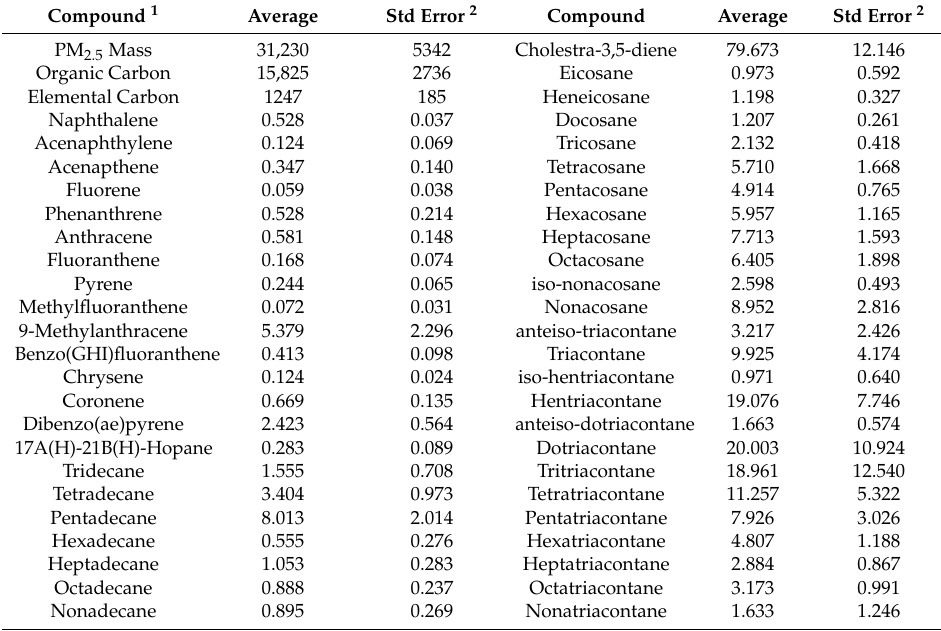
Figure 2. Mass fragments of Cholesta-3,5-diene in the surgical smoke by gas chromatography mass spectrometry—thermal desorption (GC/MS-TD) (99% match with NIST 2008 MS library). Table 1. Emission rate of organic compounds in pyrolyzed transurethral resection of a prostate (TURP)-smoke by GCMS-TD.